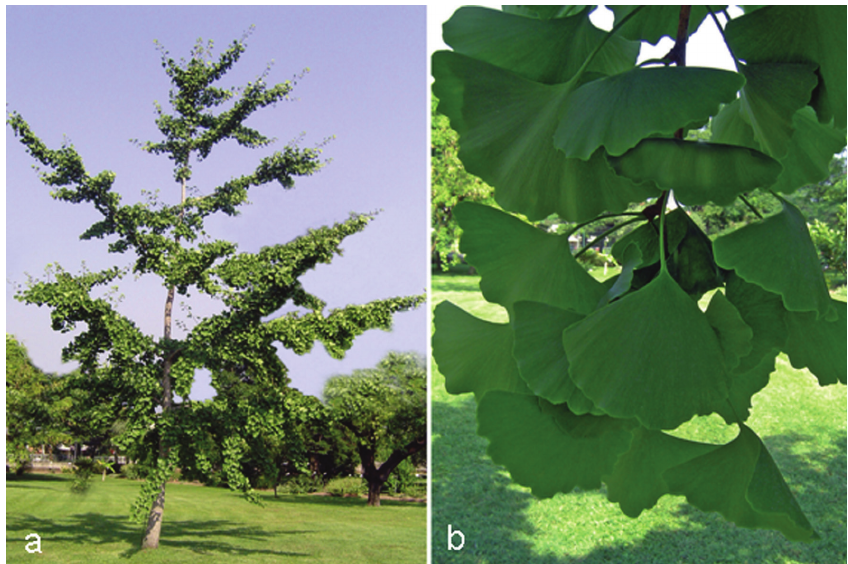
Figure 1. Ginkgo biloba L. tree (a) and its typical fan-shaped leaves